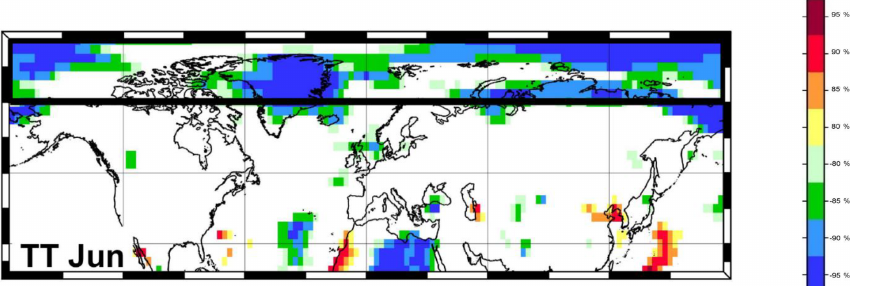
Figure 6. Stability map of the correlation between East Siberian September sea ice extent and TT Jun. Regions where the correlation is stable, positive and significant for at least 80% of the 21-year windows are shaded with dark red (95%), red (90%), orange (85%) and yellow (80%). The corresponding regions where the correlation is stable, but negative, are shaded with dark blue (95%), blue (90%), green (85%) and light green (80%). The black boxes indicate the regions used for the September sea ice extent at the end of June in addition to the variables of